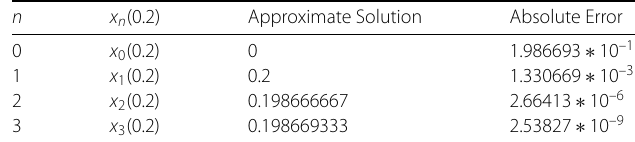
Table 1 For t = 0.2 rad, the exact solution is x (0.2) = 0.198669331 n x n